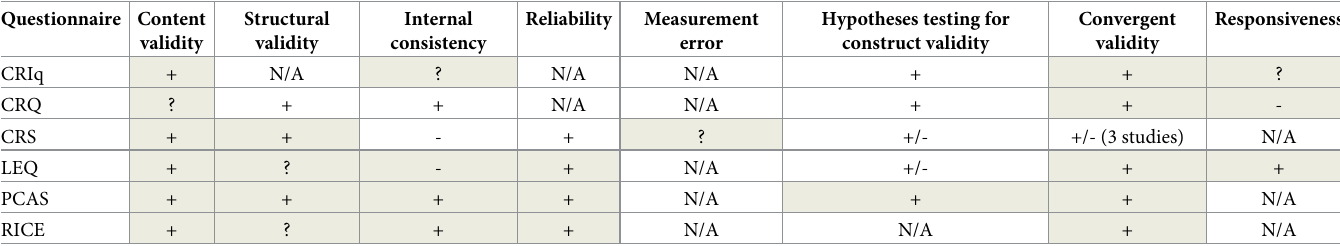
Table 5. Synthesis of measurement properties per questionnaire (terms denote quality of evidence, not the content). + or - moderate evidence positive/negative results, +/- conflicting evidence, ? Only poor methodological studies or not all information for proper assessment reported, N/A information not available Synthesis derived from a single